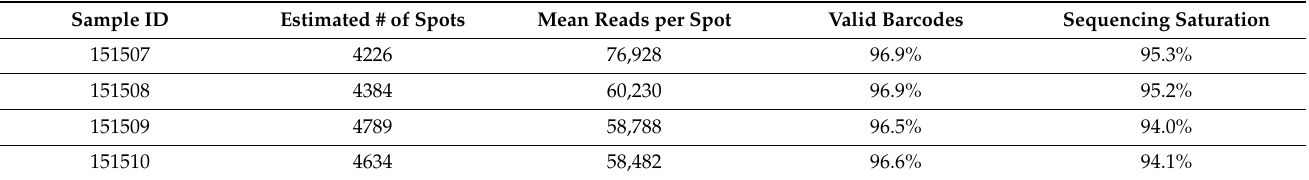
Table 1. Metrics summary of selected tissue samples, as retrieved from 10x